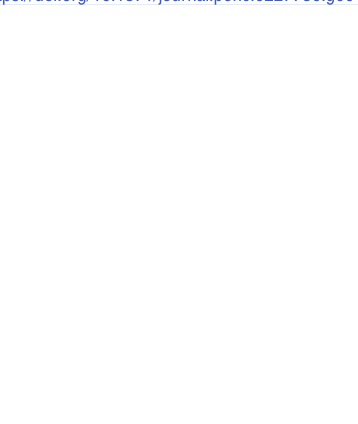
PLOS ONE | https://doi.org/10.1371/journal.pone.0227730 January 16,